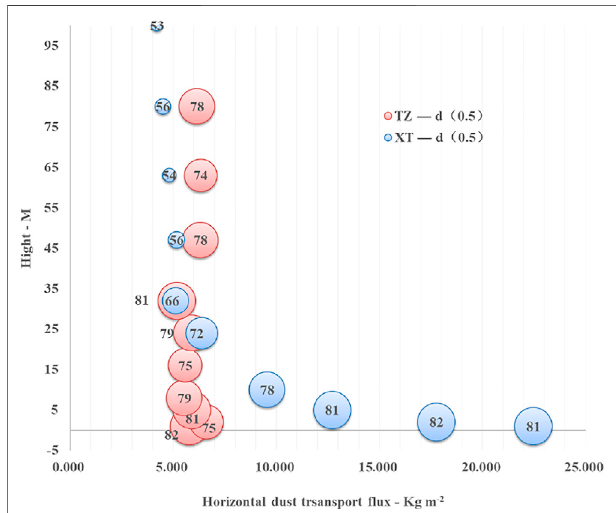
FIGURE 5 | Three-dimensional diagram of the average median particle diameter and mean horizontal dust fl ux varying with height in XT and TZ (the values in the spheres represent the d (0.5) median particle